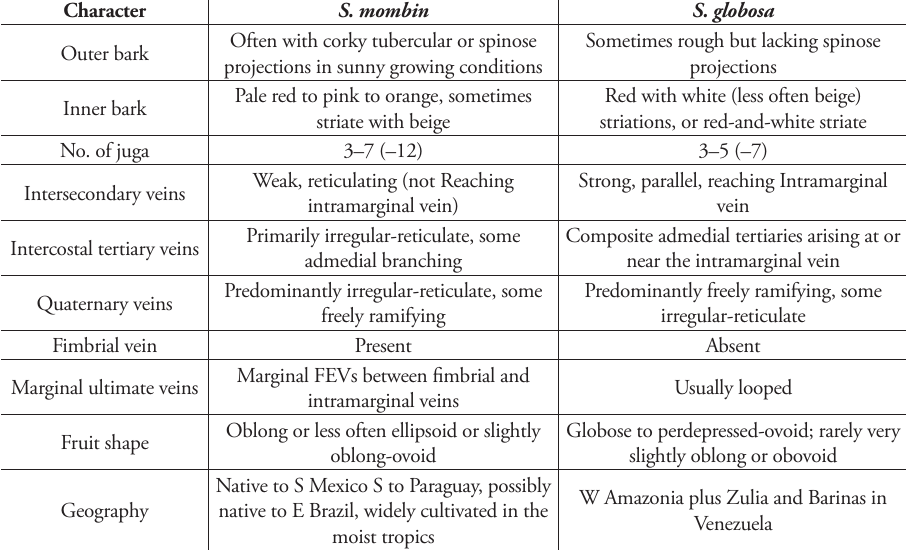
Table 4. Comparison of Spondias mombin and S. globosa